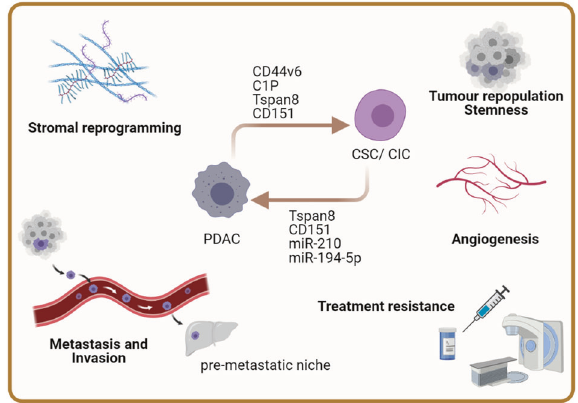
Fig. 2 The EV-mediated communication between PDAC and cancer stem cell/cancer-initiating cell (CSC/CIC). PDAC cell- derived EVs contain cargos such as CD44v6, C1P, Tspan8 and CD151, while CSC/CIC-derived EVs carry factors including Tspan8, CD151, miR210 and miR-195-5p that regulate biological functions in the counterparts. This includes upregulation of stemness